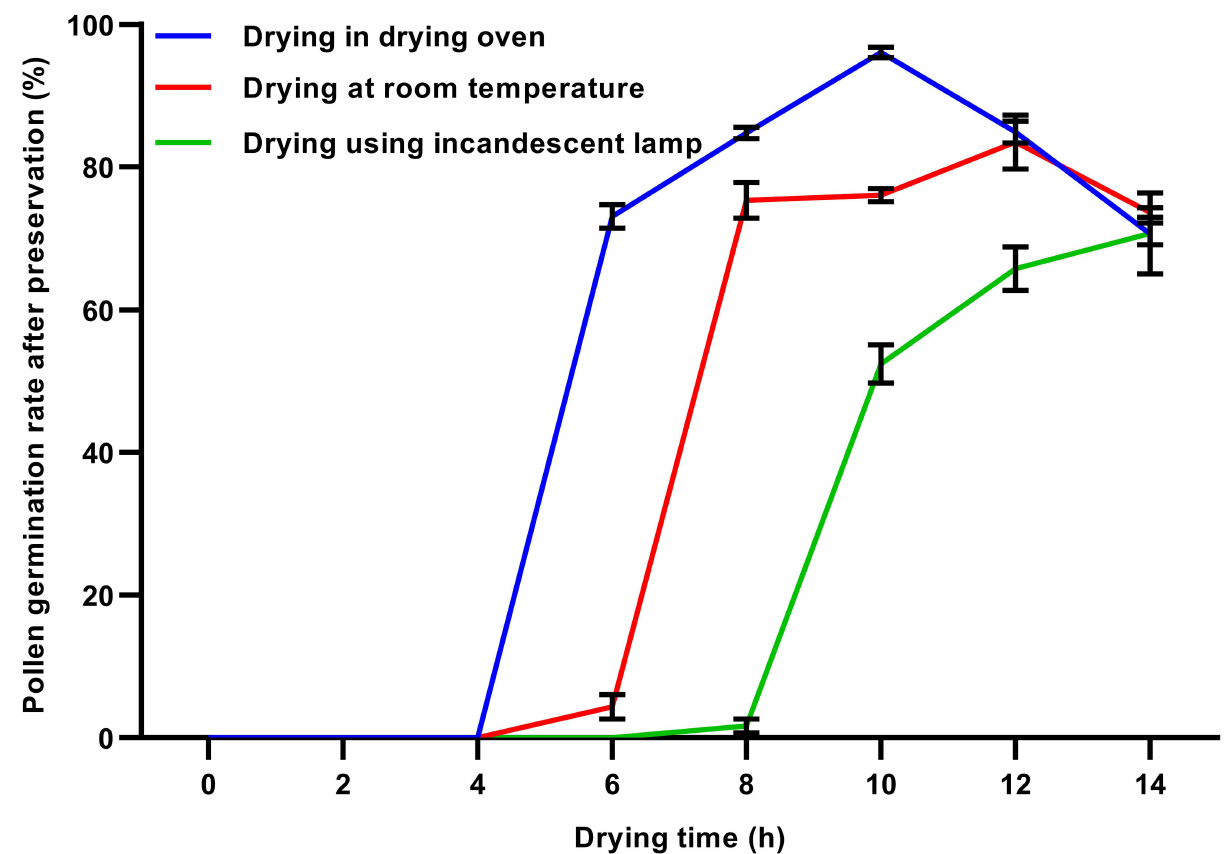
FIGURE 3 | Effects of different dehydration treatments on pollen germination rates after preservation. The flowers were collected at the initially-open stage, dehydrated under three treatments at different times, frozen in liquid nitrogen (LN) for 72h, and thawed at room temperature. All data were represented as mean ± SD of three